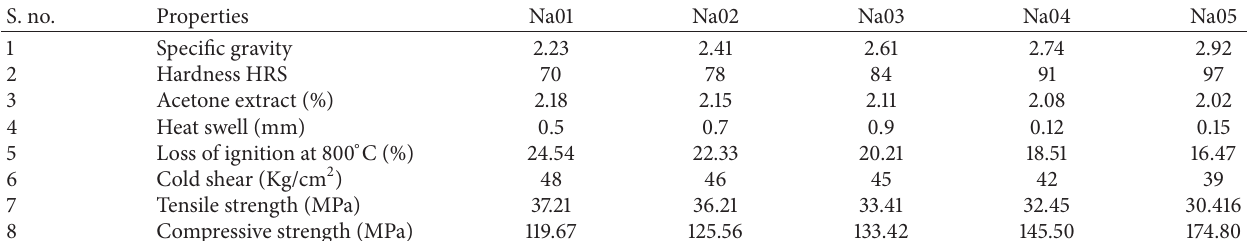
Table 3: List of various physical, thermal, and mechanical